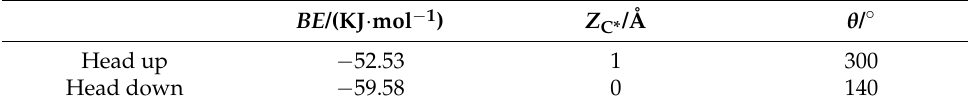
Table 3. Binding energies for SA/ β -CD calculated by PM3 method.